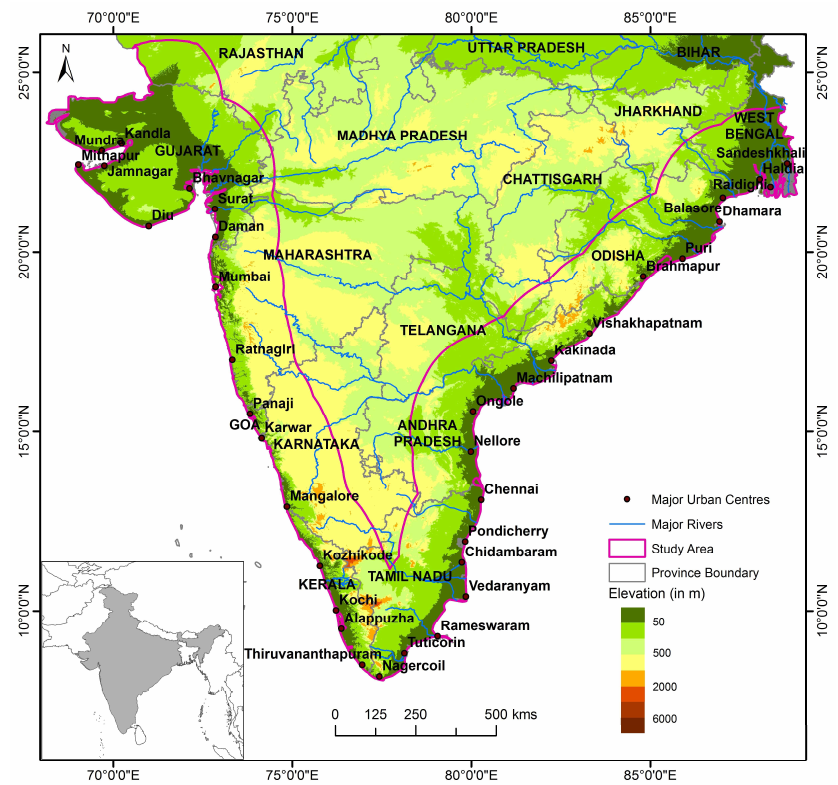
Figure 1. India with the study area shown (200-km buffer zone inland from the actual coastline). Major rivers, provincial boundaries, and major urban centers along coastal India are indicated in the figure.